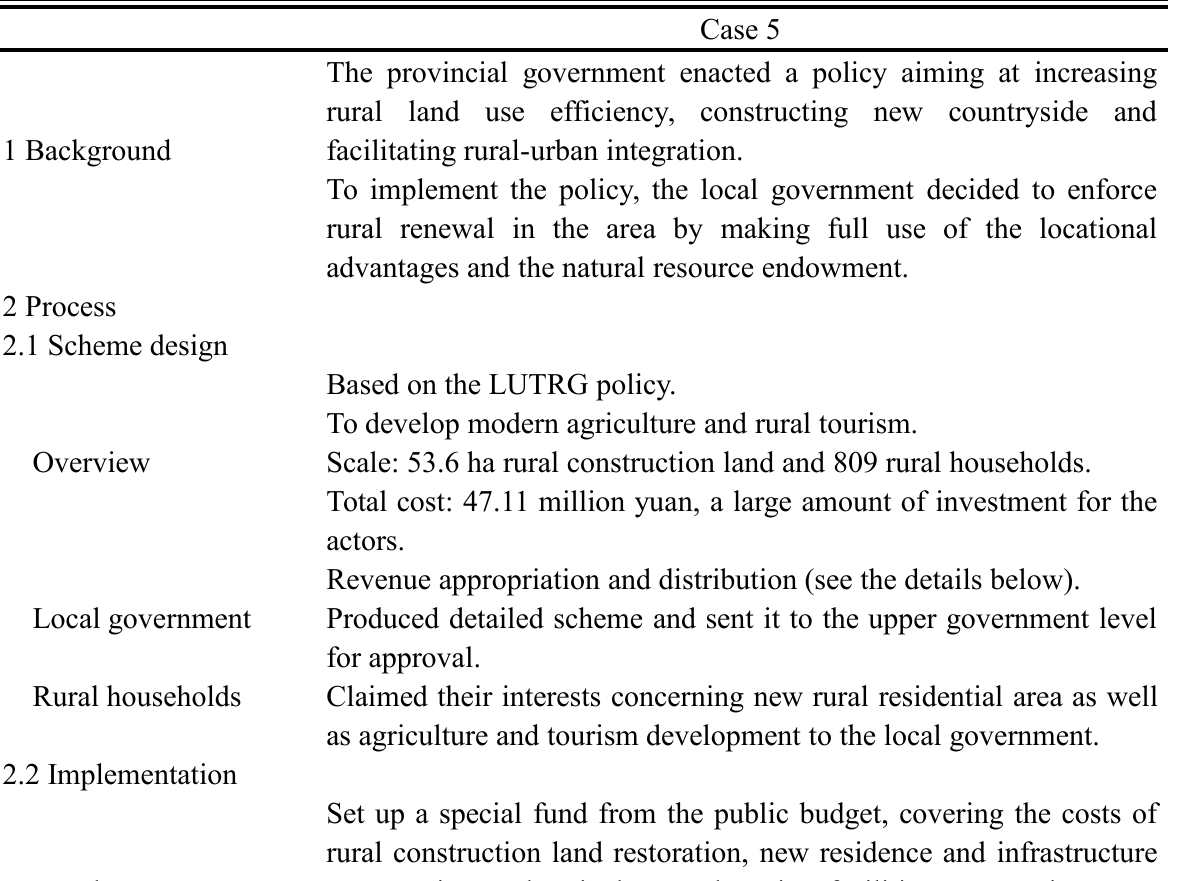
Table A3.4: Archetype 4 Government participation in large-scale rural renewal with a long-term